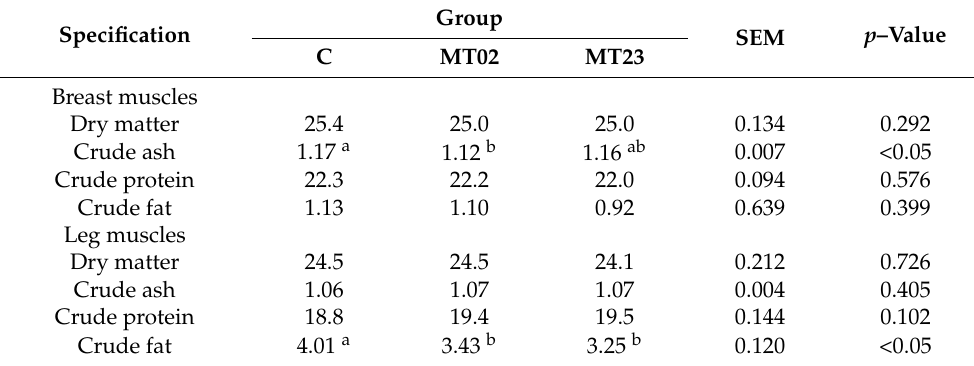
Table 5. Basic nutrients (g/100 g) of muscles.